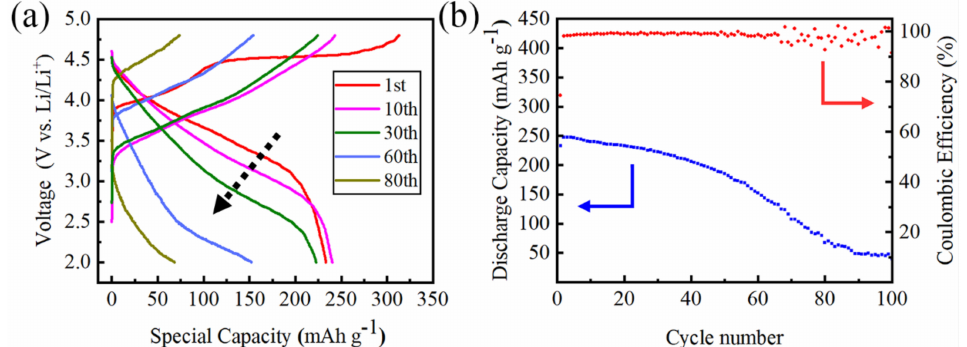
Figure 3. ( a ) The charge/discharge curve of Li[Li 0.2 Ni 0.13 Mn 0.54 Co 0.13 ]O 2 for different cycles. ( b ) The cycling performance of Li[Li 0.2 Ni 0.13 Mn 0.54 Co 0.13 ]O 2